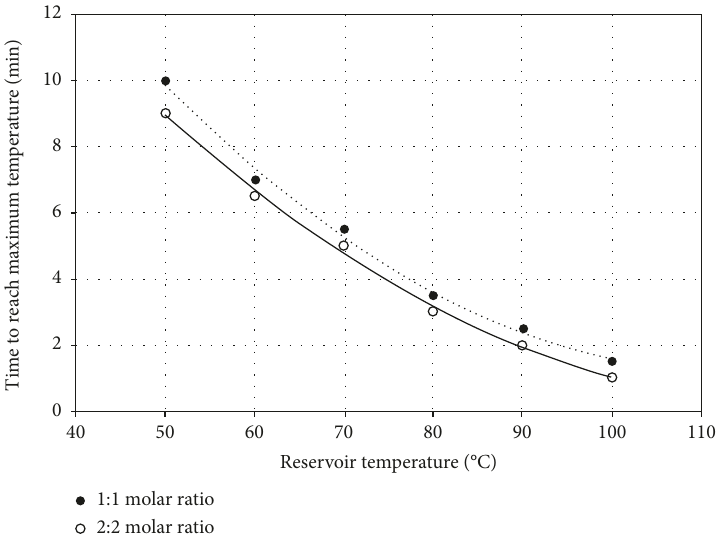
Figure 8: Time to reach the maximum reaction temperature as a function of the reservoir